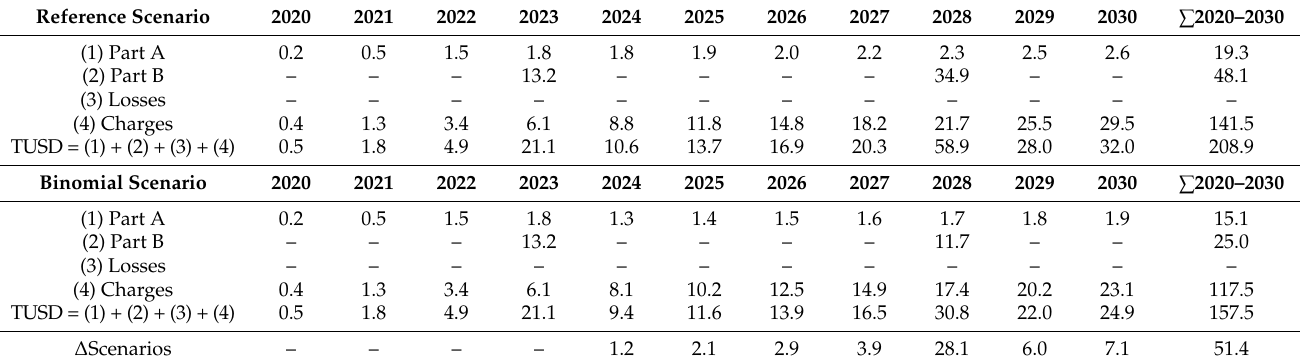
Table 11. Economic effects of MMDG for Enel Rio, in million